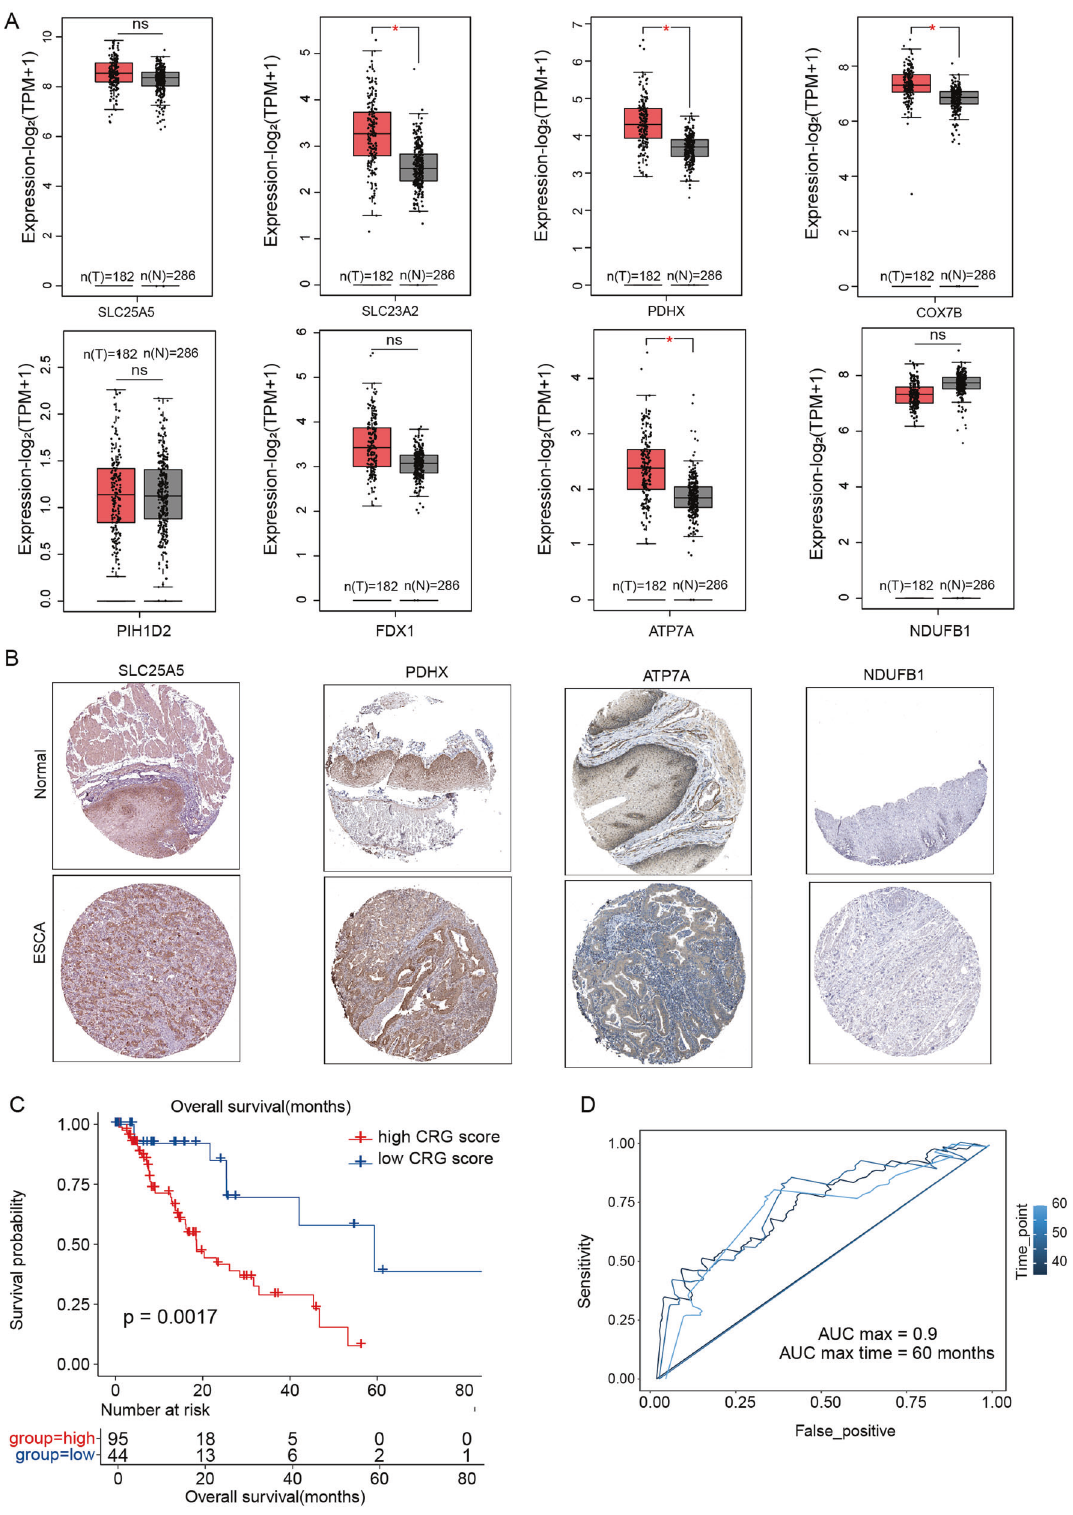
Fig. 3 Construction of the minimal CRGs signature that predicted the survival of ECSA patients. A Differential gene expression of the prognostic CRGs between normal samples and ESCA samples. The data was from the GEPIA2 database. B Representative images showed the differential protein level of the prognostic CRGs between normal samples and ESCA samples. The data was from The Human Protein Atlas database. C Kaplan-Meier survival curves of the CRGs- signature in ESCA patients. D The 3-, 4-, and 5-year ROC curves for CRGs- signature in ESCA patients. Data was exhibited as mean ± SD. Signi fi cance were assessed by Wilcoxon test ( A ) and log-rank test ( C ). ns = not signi fi cant, * P < 0.05; ** P < 0.01; *** P <